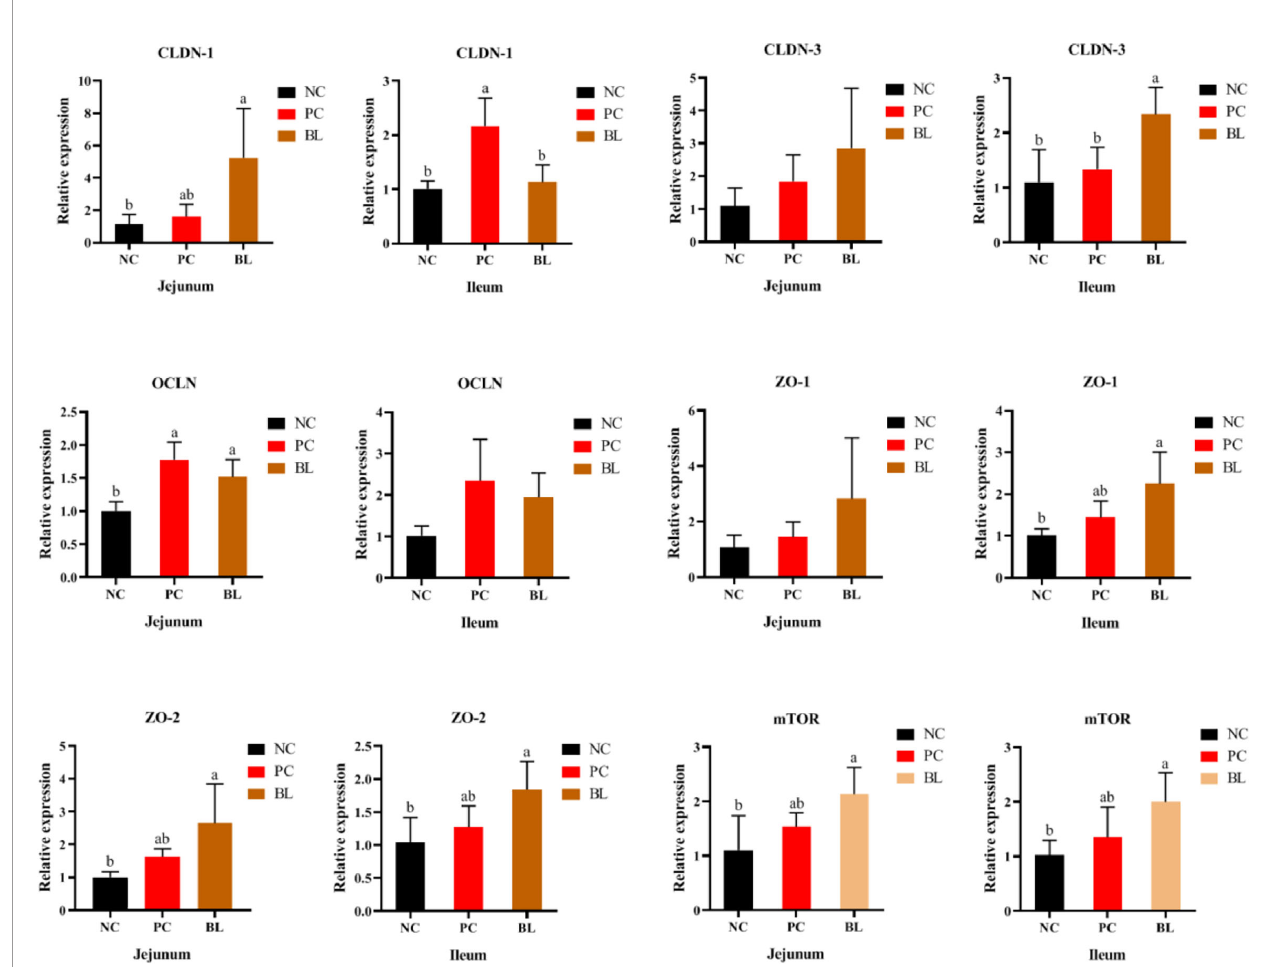
FIGURE 3 | Relative mRNA expressions of mTOR, CLDN-1, CLDN-3, OCLN, ZO-1, and ZO-2 in the jejunum and ileum of broiler chickens (n = 6, mean with SD). a, b means with different letters are signi fi cantly different ( P < 0.05). One-way ANOVA and adjustment for multiple comparisons were